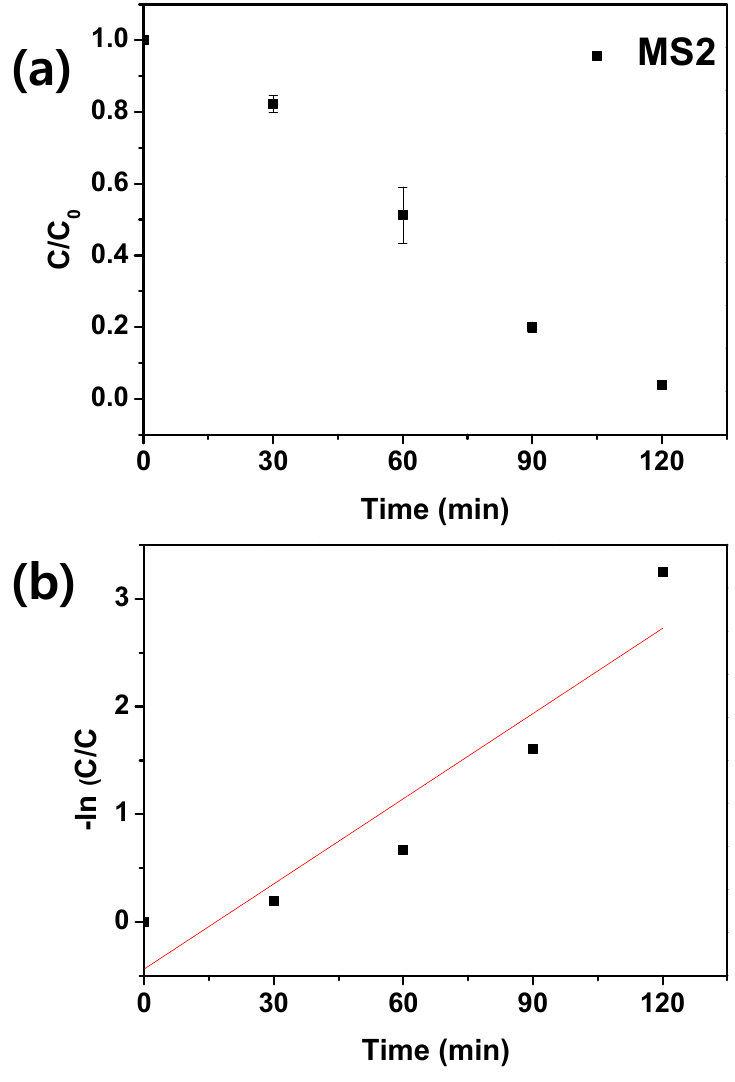
Figure 9. ( a ) Degradation of bacteriophage MS2 by 4% PANI/TiO 2 under visible-light irradiation, and ( b ) pseudo-first-order kinetics of MS2 degradation (MS2 = 10 5 CFU/mL, catalyst dose: 1.33 g/L).